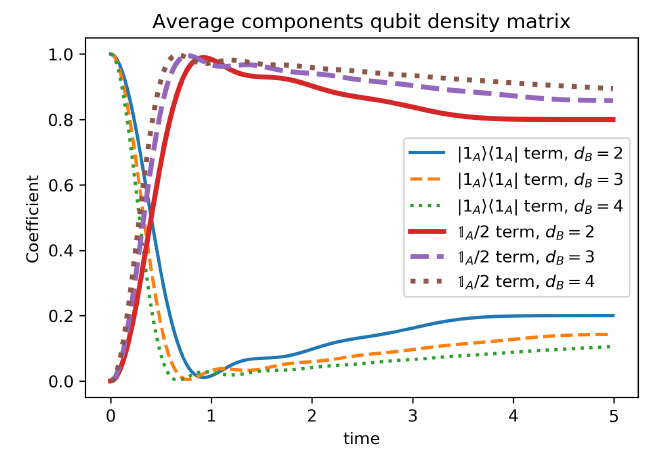
〉〈 1 | vs 1 / d in the 〈〈 ρ A A A A